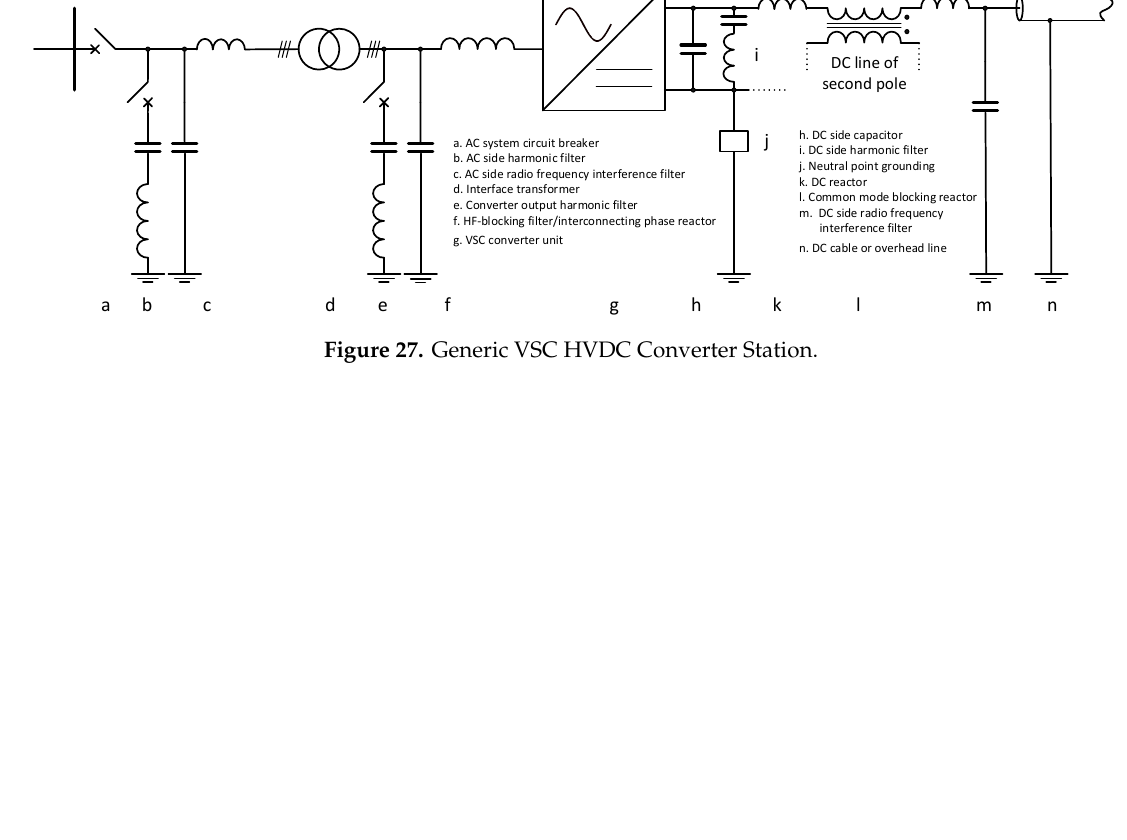
Figure 26. Output voltage (fundamental frequency switching).